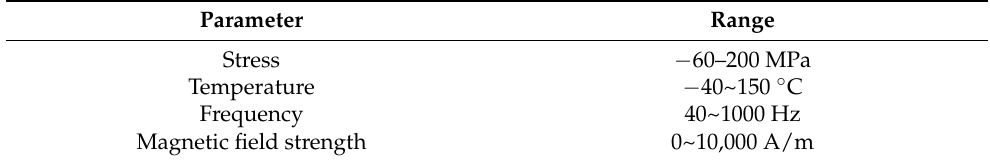
Table 2. Test range of the testing